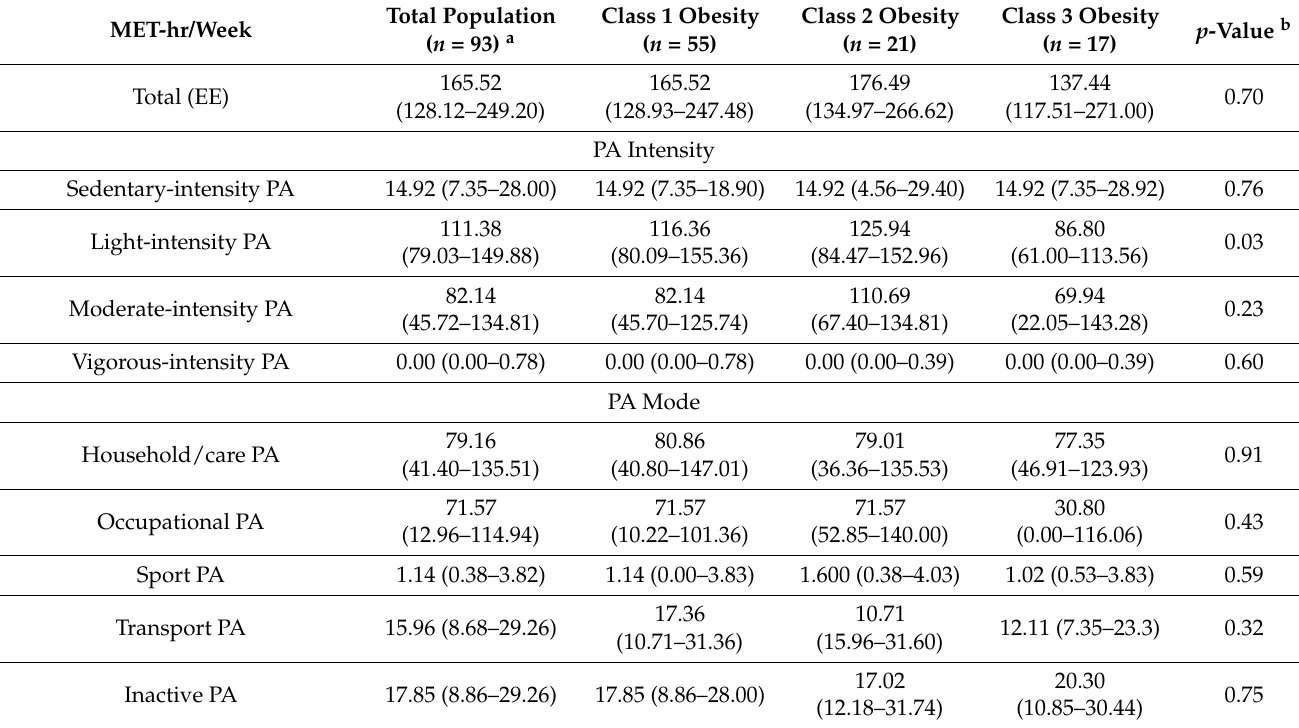
Table 4. Physical activity patterns for the total population overall and stratified by obesity